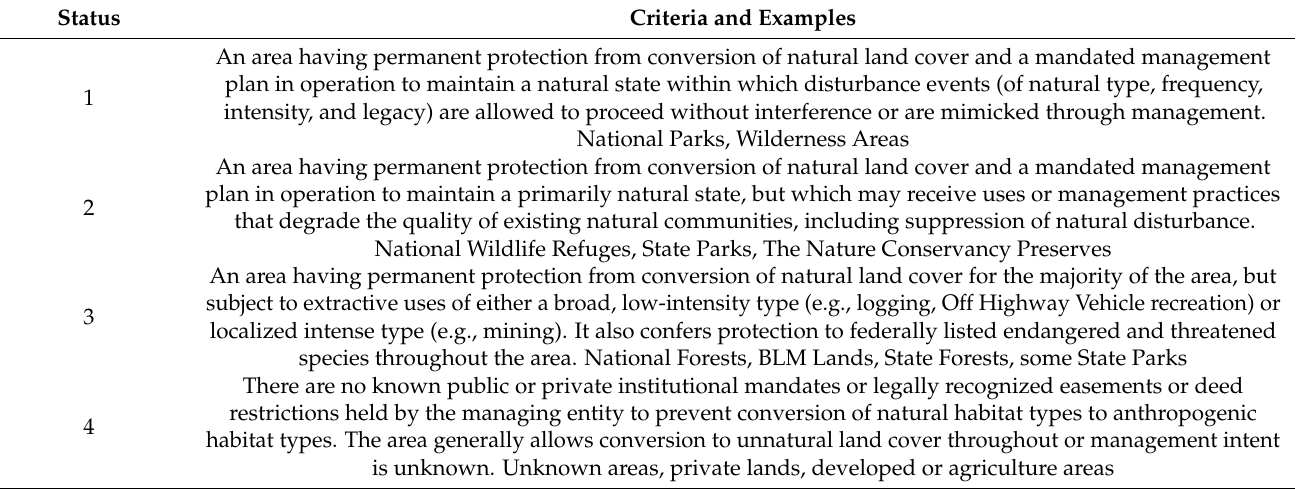
Table 2. GAP Status Codes (USGS GAP